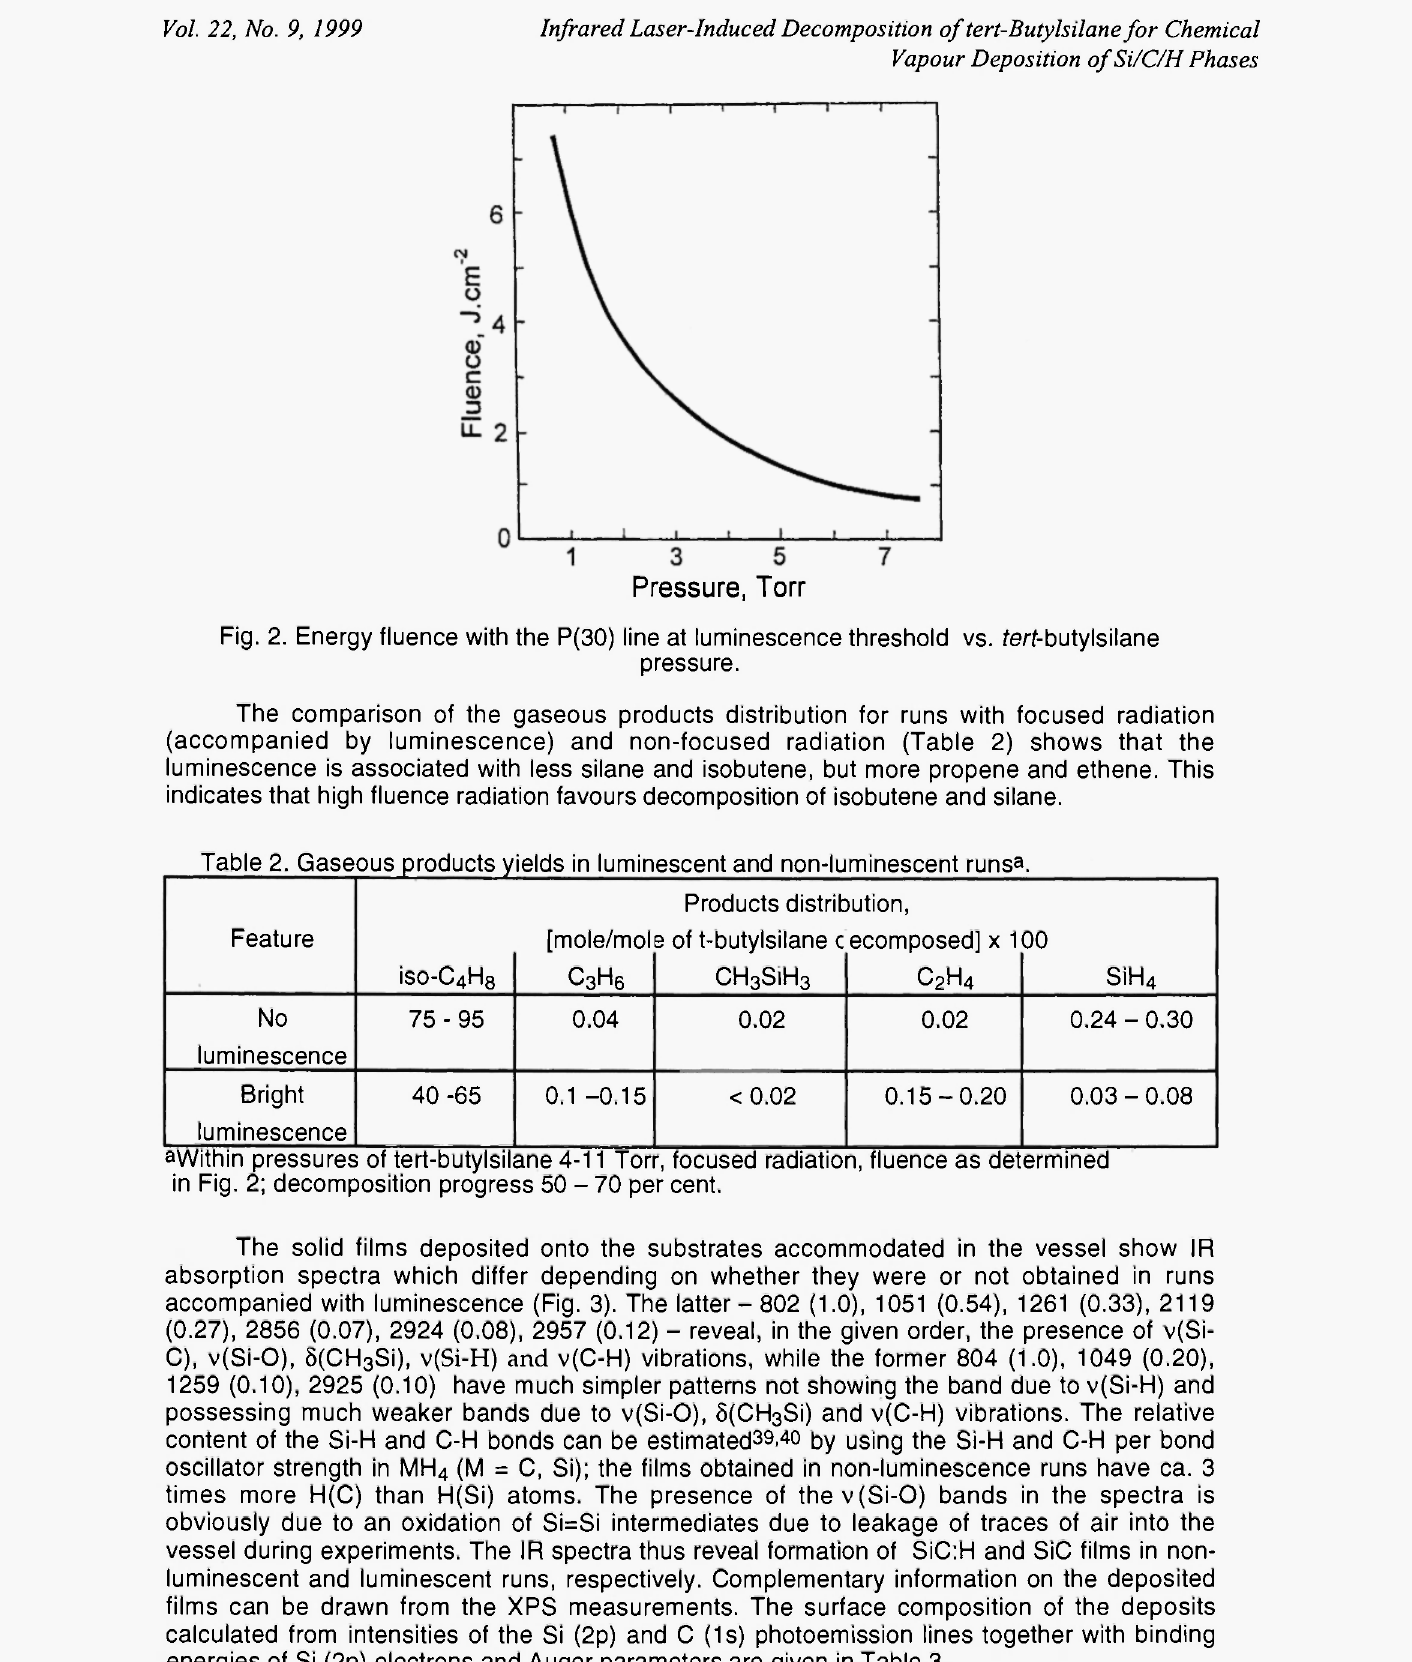
Table 2. Gaseous products yields in luminescent and non-luminescent runs 3 . Products [mole/mol ΟβΗβ iso-C/jHe